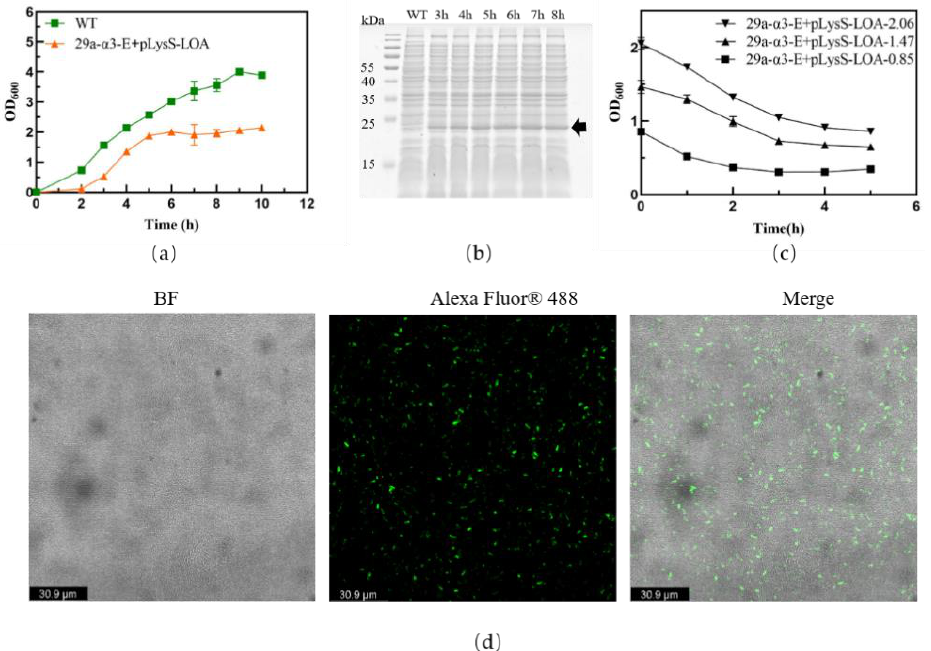
Figure 2. Lpp-OmpA-ATRAM on the EcN/ ∆ tnaA ::T7 RNAP membrane surface. ( a ) The growth curves of EcN/ ∆ tnaA ::T7 RNAP/pLysS-LOA and EcN/ ∆ tnaA ::T7 RNAP (WT). ( b ) SDS-PAGE gel photo showing expression levels of Lpp-OmpA-ATRAM over time. The black arrow indicates the target protein. ( c ) Lysis curves of EcN/ ∆ tnaA ::T7 RNAP/ pET29a- α 3-E after different induction starting points. ( d ) Confocal images of Lpp-OmpA-ATRAM on the engineered bacterial membrane surfaces. The green fluorescence is derived from the expression of Lpp-OmpA-ATRAM, scar bar is 30.9 µm .